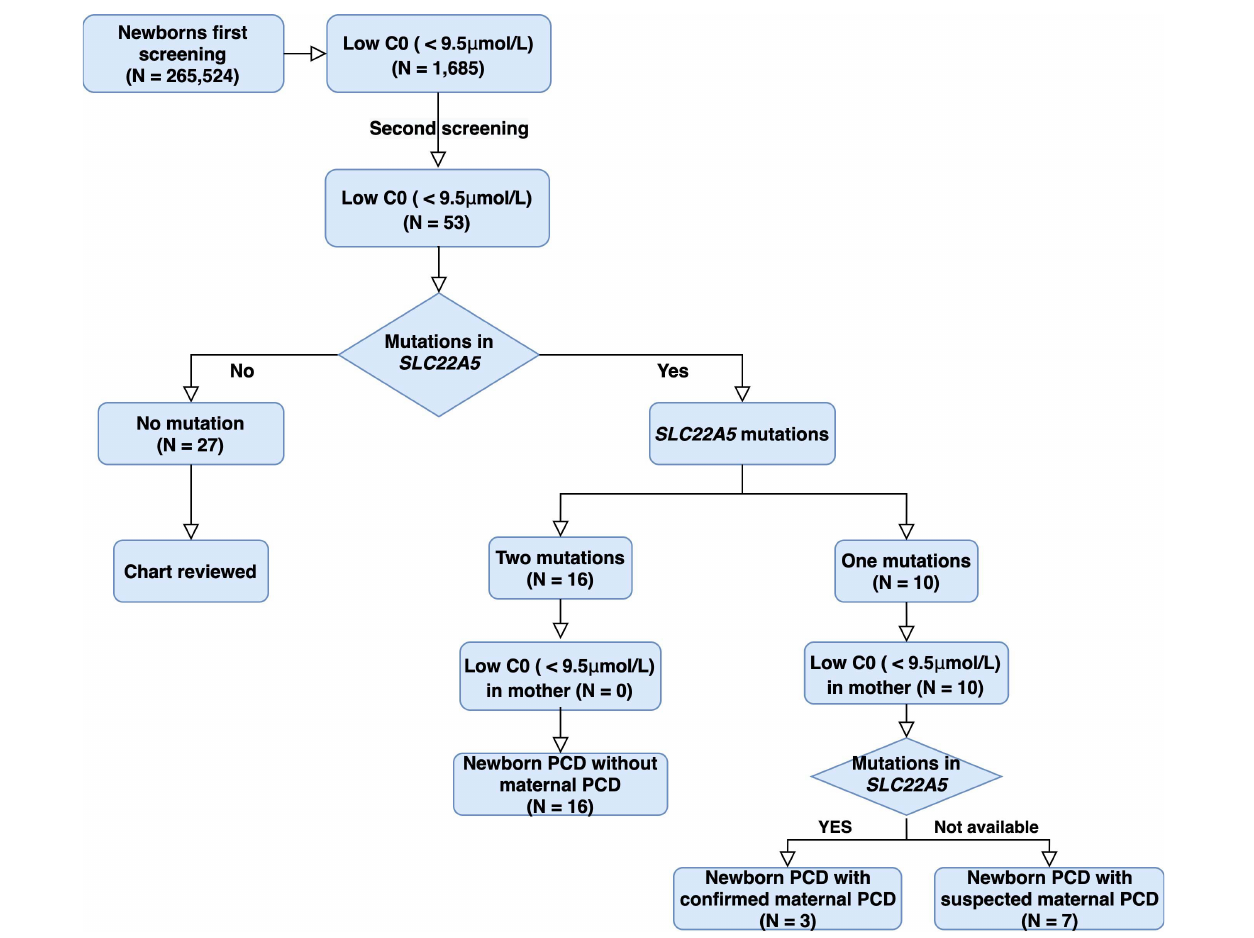
FIGURE 1 | Study design and pipeline of PCD identification by NBS and genetic analysis in Ningbo city. C0: free carnitine; PCD: Primary carnitine